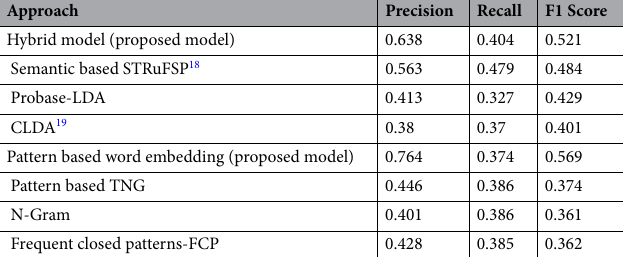
Table 5. Result comparison of different algorithms with the proposed model.